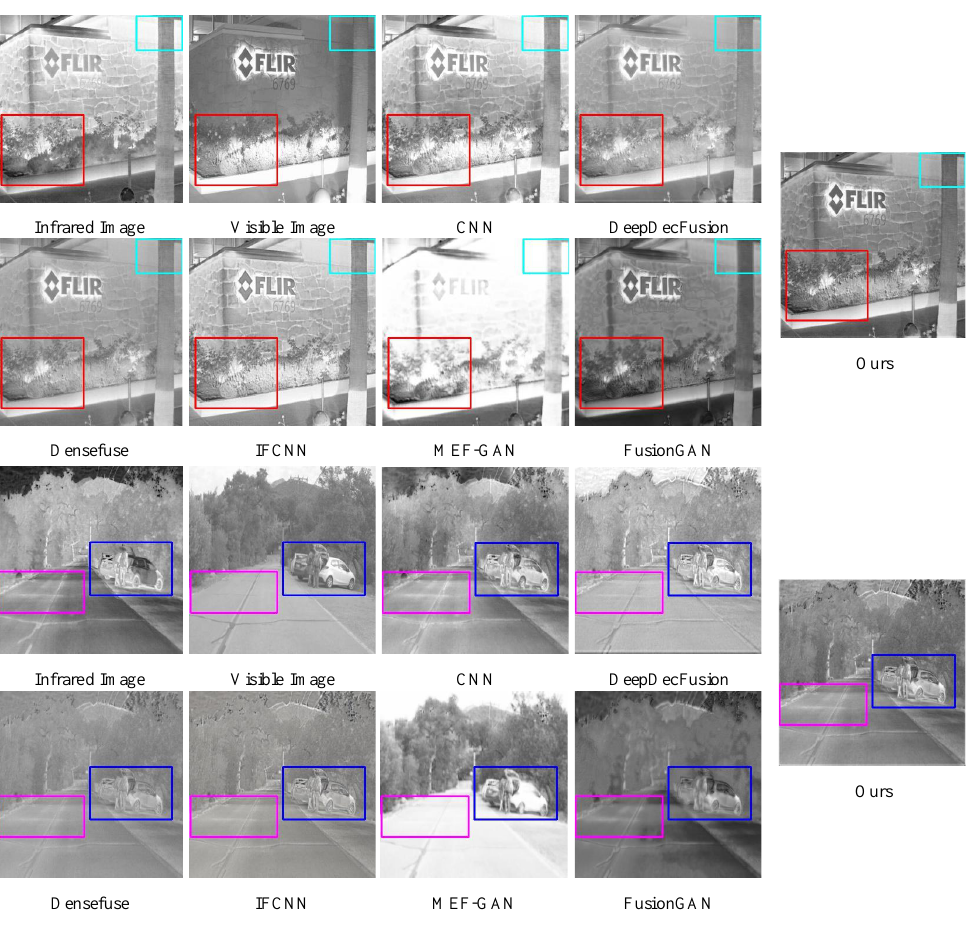
Figure 5. The Result of Road